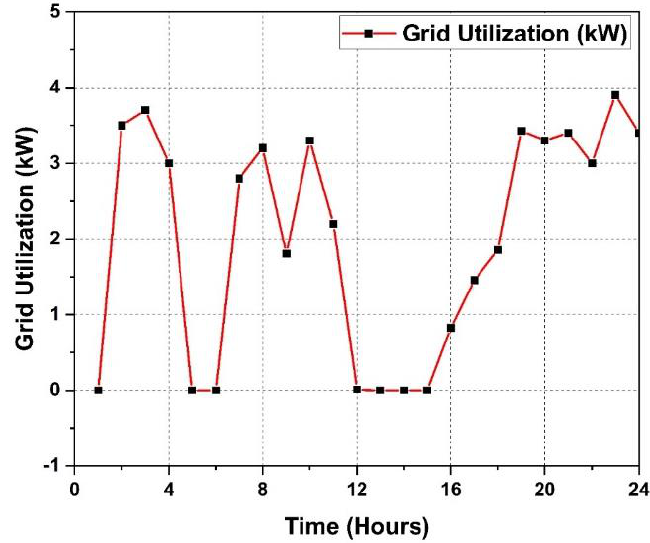
Figure 8. Grid utilization to load (on− grid).